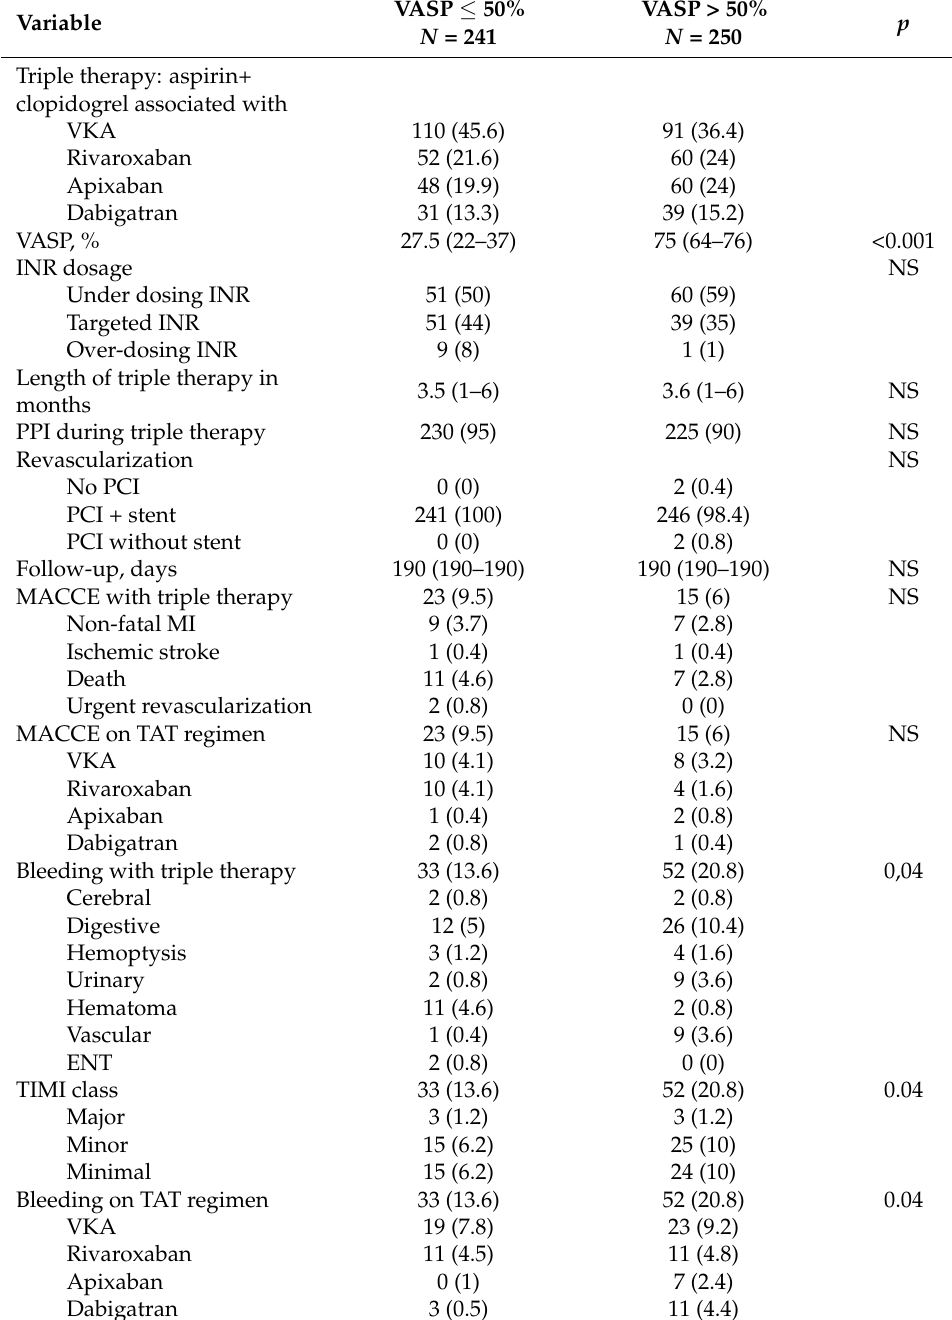
Table 4. Indication for anticoagulation, major adverse cardiac or cerebrovascular events and bleeding for patients with six months follow-up, VASP cut-off 50% ( N =